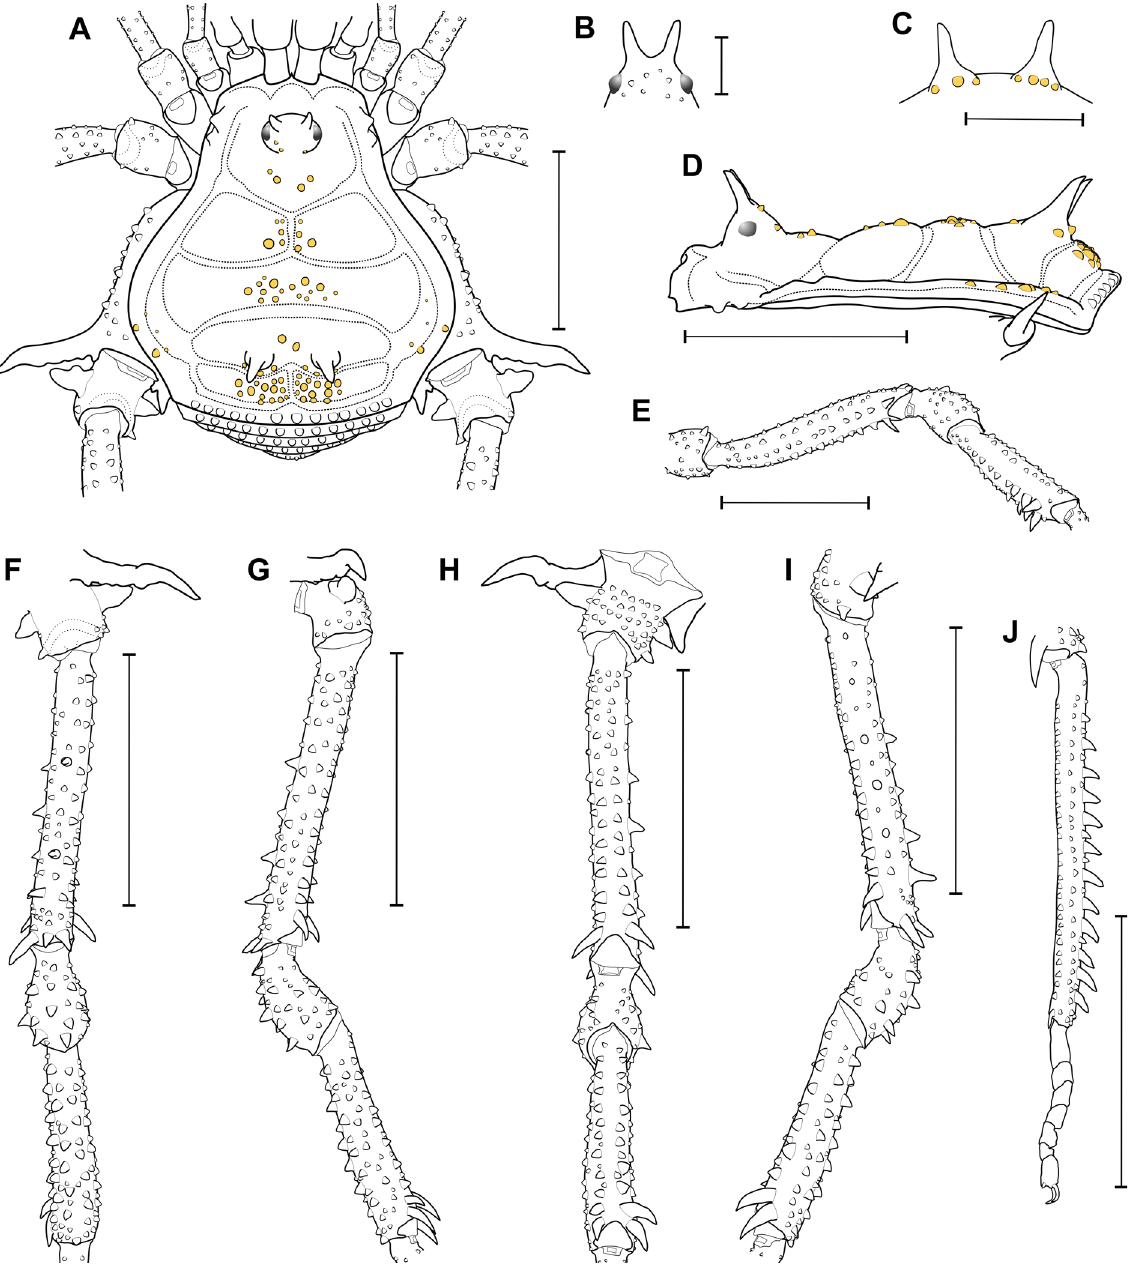
Fig. 17. Lacronia serripes (Mello-Leitão, 1923), ♂ (MZSP 14342). A . Habitus, dorsal view. B . Ocularium, frontal view. C . Armature of mesotergum area III, posterior view. D . Habitus, lateral view. E . Left Fe– Ti III, proventral view. F . Right Fe–Ti IV, dorsal view. G . Same, prolateral view. H . Same, ventral view. I . Same, retro-lateral view. J . Right Mt–Ta IV, retro-lateral view. Scale bars: A, D–E, J = 2 mm; B–C = 1 mm; F–I = 3